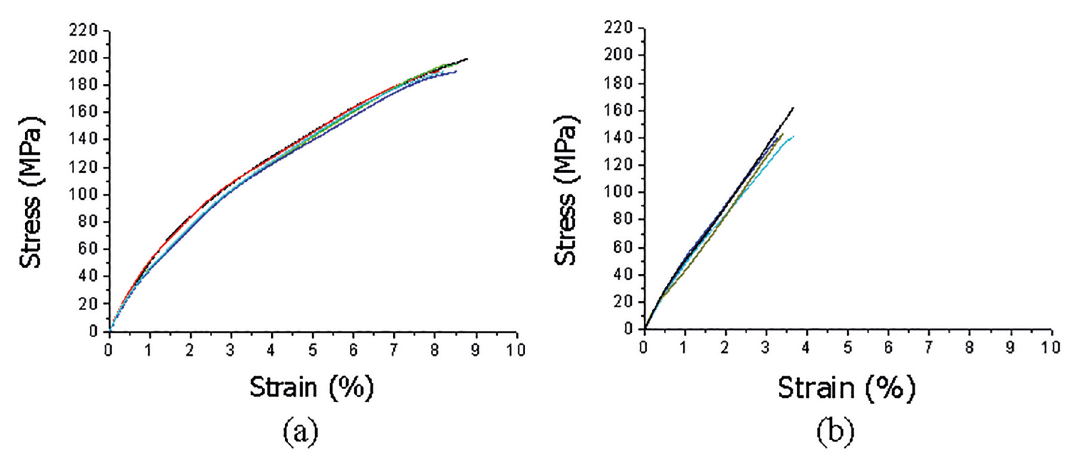
Figure 4. Stress x strain diagram (uniaxial tensile test): (a) HSCL; (b)